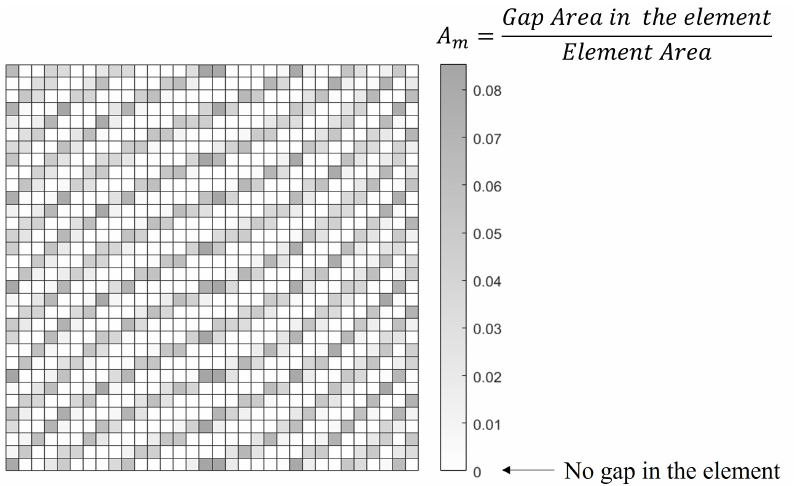
Figure 5. Scaled material properties according to gap area